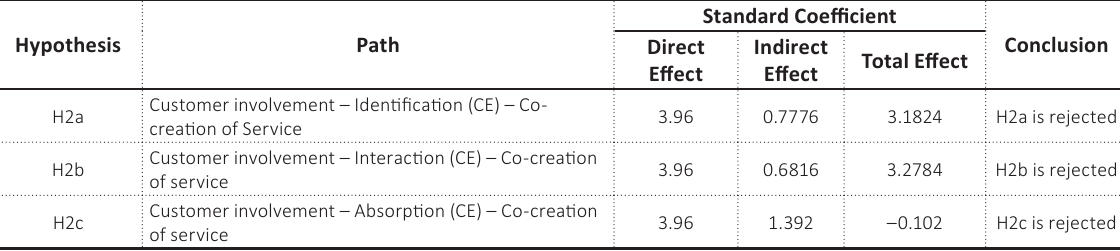
Table 4. Standardized direct effect, indirect effect, and total effects Hypothesis